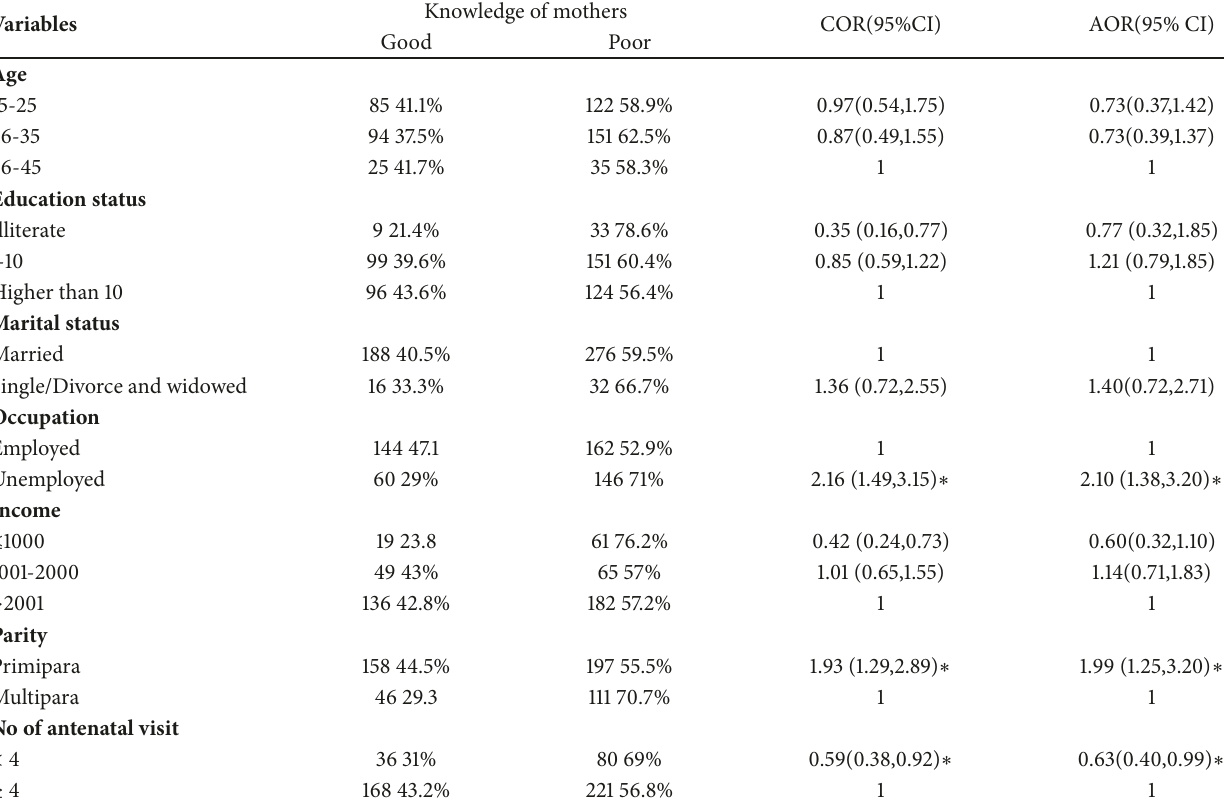
Table 2: Factors associated with poor maternal knowledge on newborn care in Addis Ababa health centers, Dec. 1-Jan. 30,